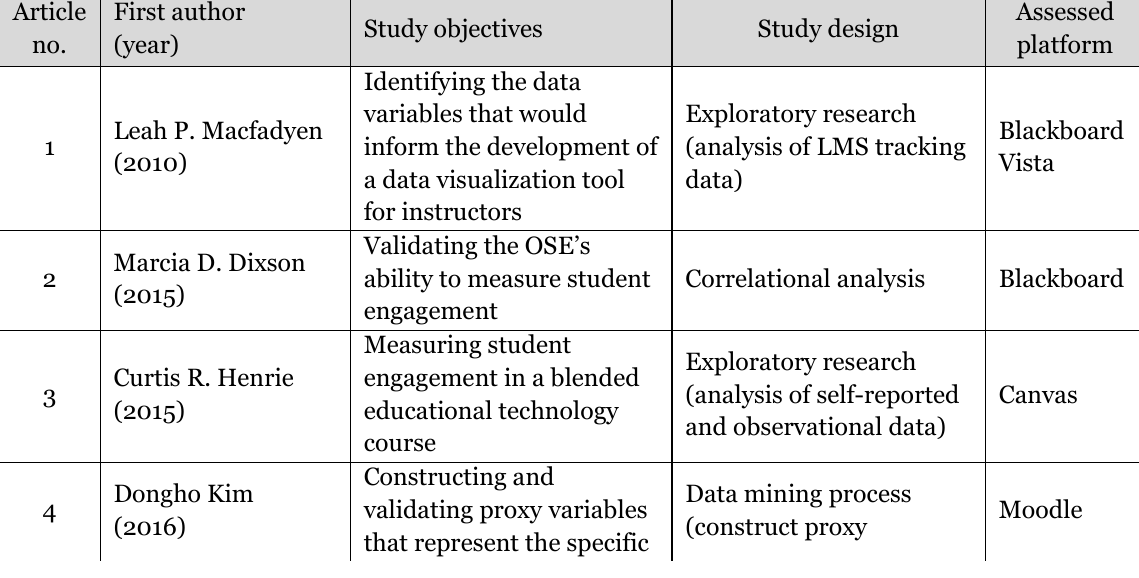
Bibliographic Information of Included Articles in Chronological